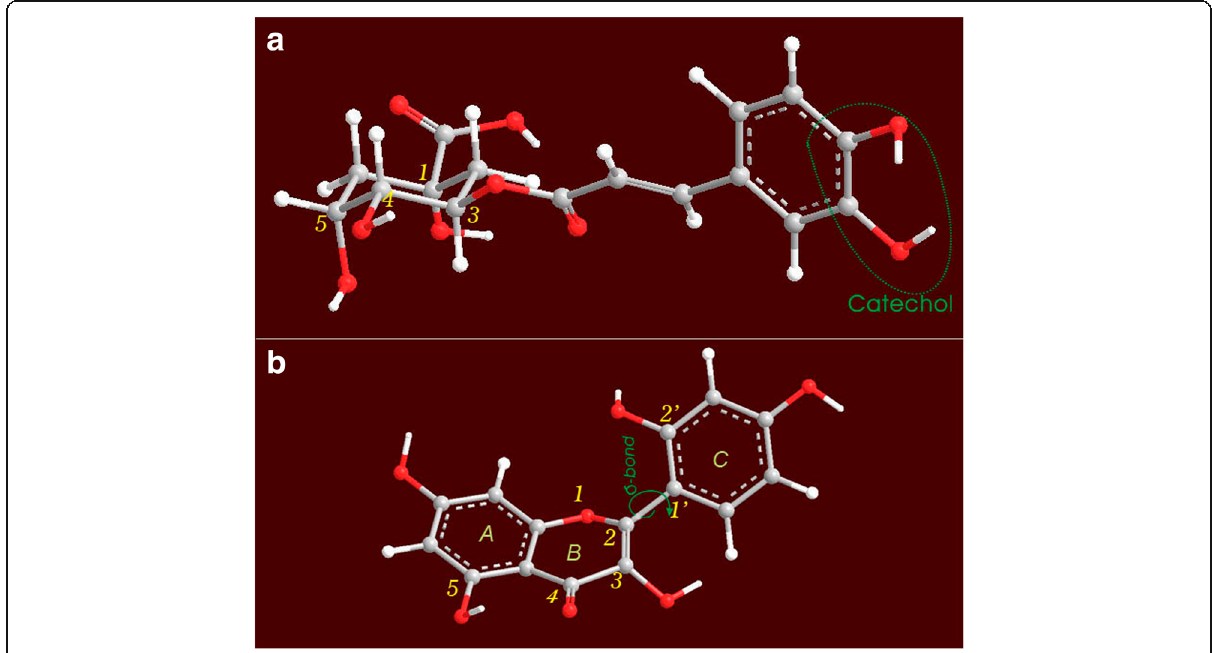
Fig. 6 The preferential conformation-based ball-stick models of chlorogenic acid ( a ) and morin ( b ). (The models were created by ChemOffice 2004,